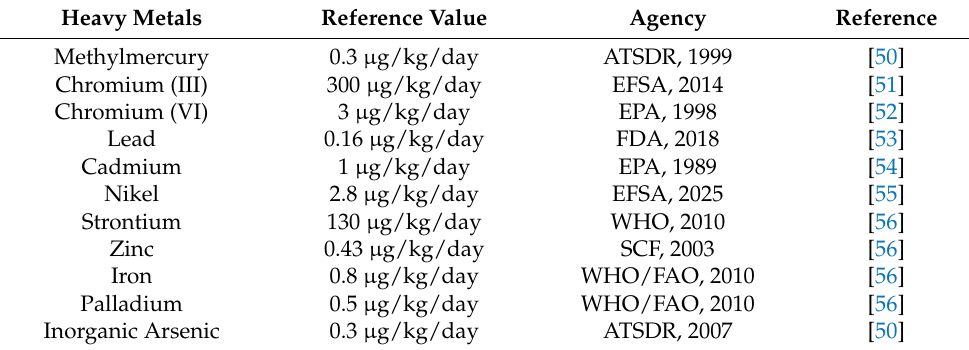
Table 1. The reference values of heavy